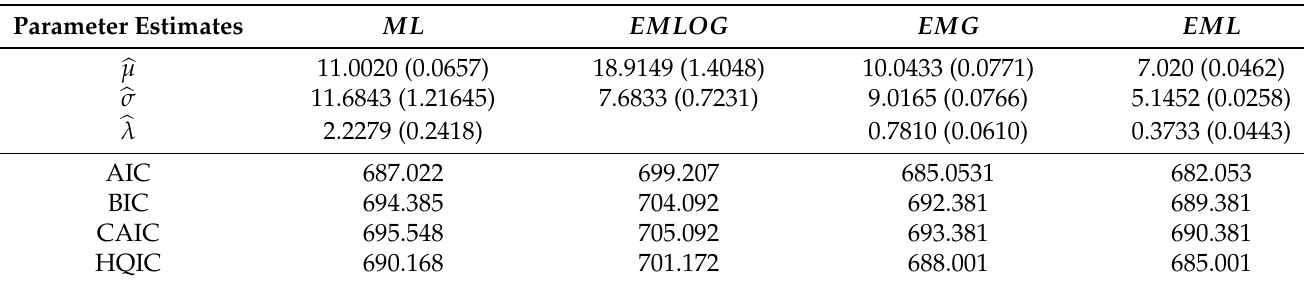
Table 5. Maximum likelihood estimators for ML , EMLOG , EMG , and EML models for the soil nickel concentration data set, with their corresponding standard deviations in parentheses and comparison criteria AIC, BIC, CAIC, and HQIC.